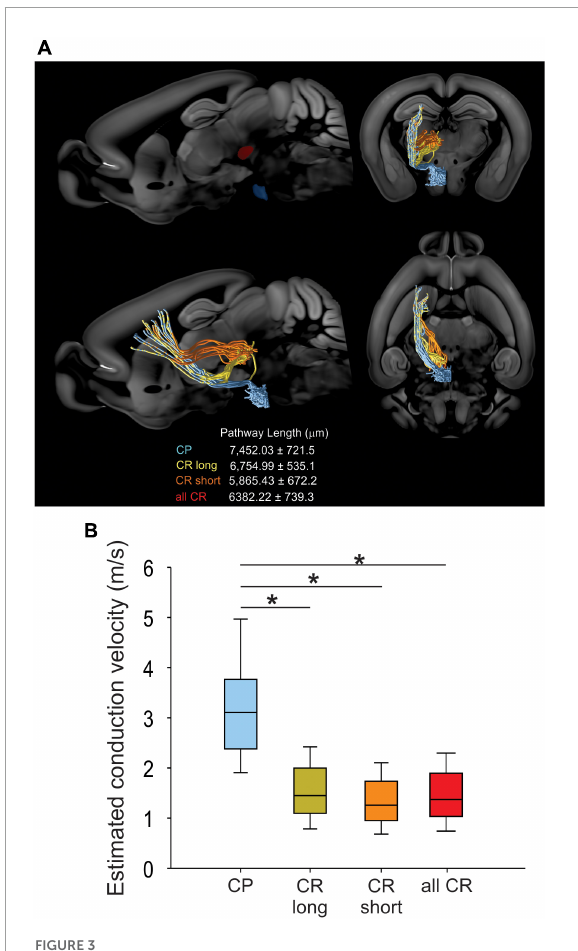
FIGURE3 CR and CP neurons conduct at different velocities. (A) Visual tractography reconstructed from 30 axonal tracing experiments from the Allen Mouse Brain Connectivity Atlas, showing the target ROIs and the pathway length from CP and CR axons traveling through the thalamus (orange CR short) or substantia nigra (yellow CR long) in the different anatomical planes. (B) Comparison between the conduction velocities computed from conduction times ( Figure 2C ) and mean pathways lengths. Boxplots represent the median and 10–90 interquartile range. ∗ p < 0.01 Kruskal-Wallis, One Way ANOVA, Dunn’s post-hoc